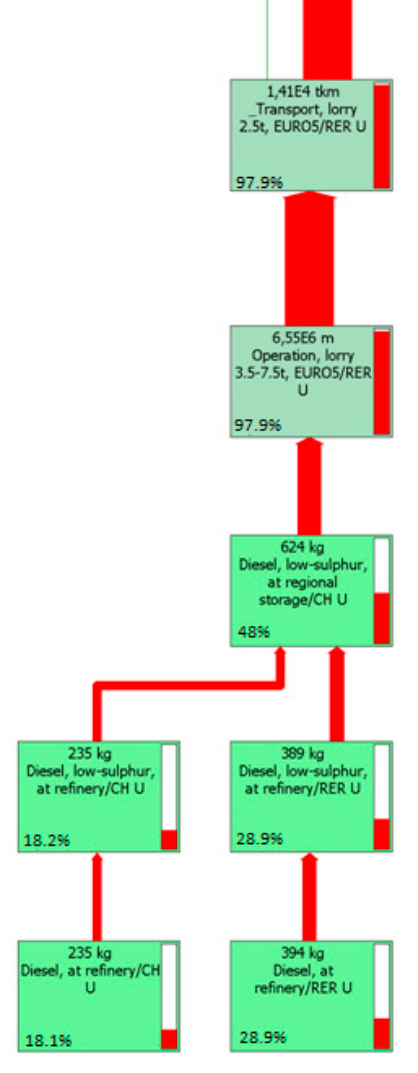
Figure 6. Network tool on cumulative score.